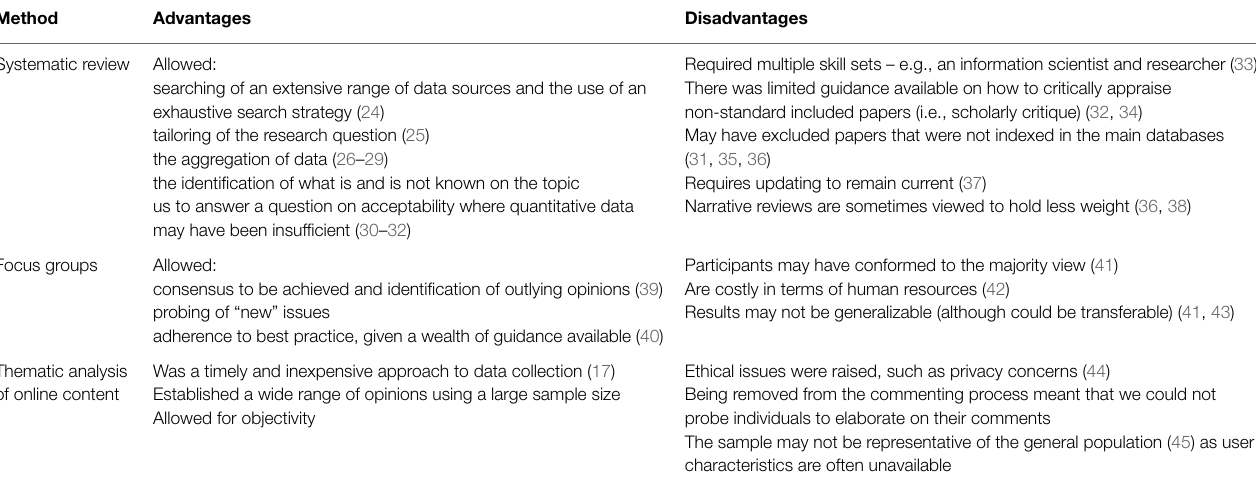
TABLE 2 | A comparison of methodological approaches